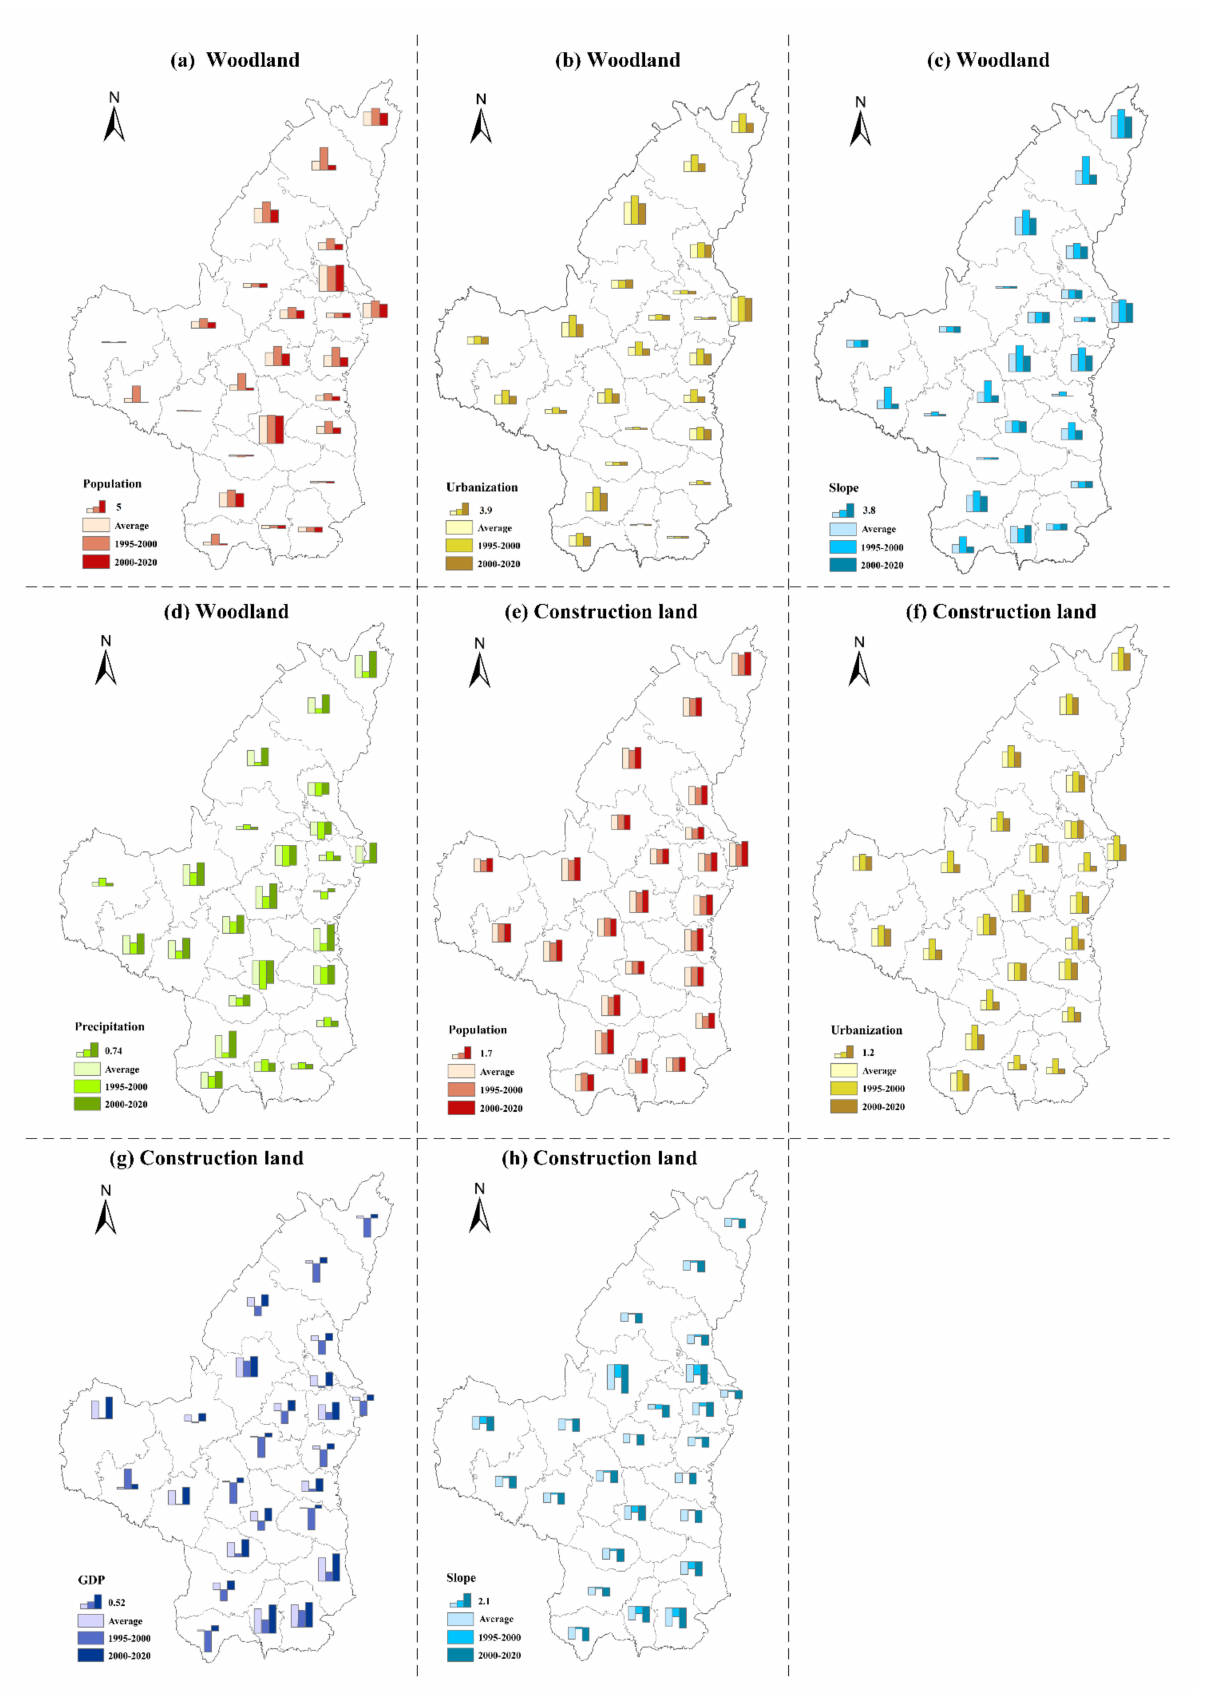
Figure 5. The mean regression coefficients of core factors for woodland and construction